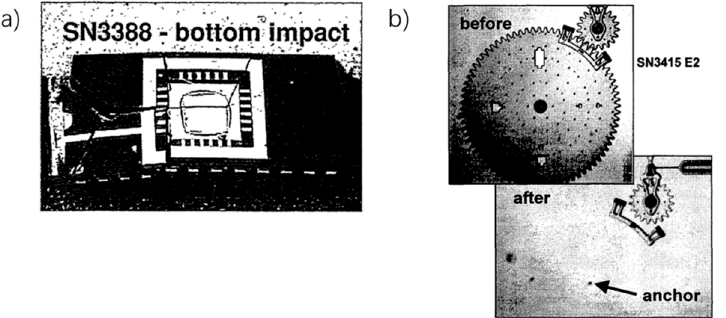
Figure 5. ( a ) fracture of MEMS chip under 40,000 g shock ( b ) Micro gear fracture under 20,000 g shock [46,47].